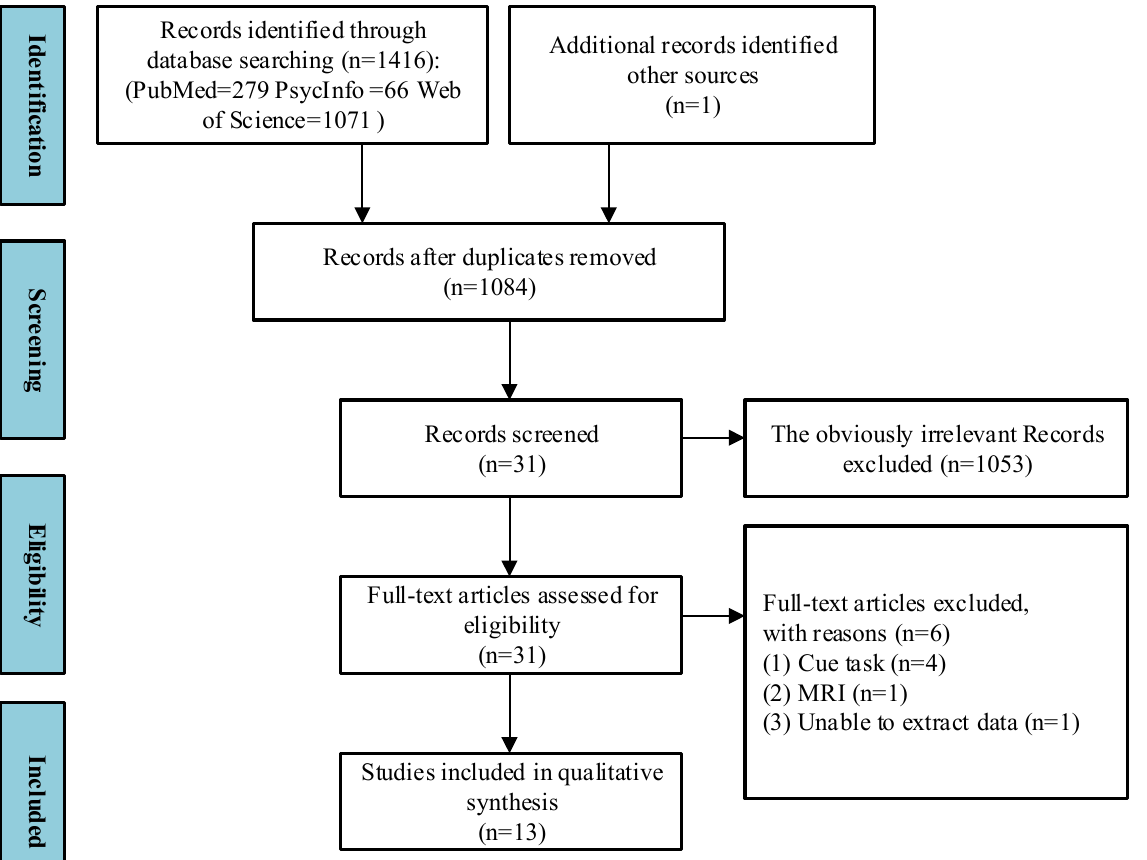
Figure 1. Flow diagram showing the study selection process.